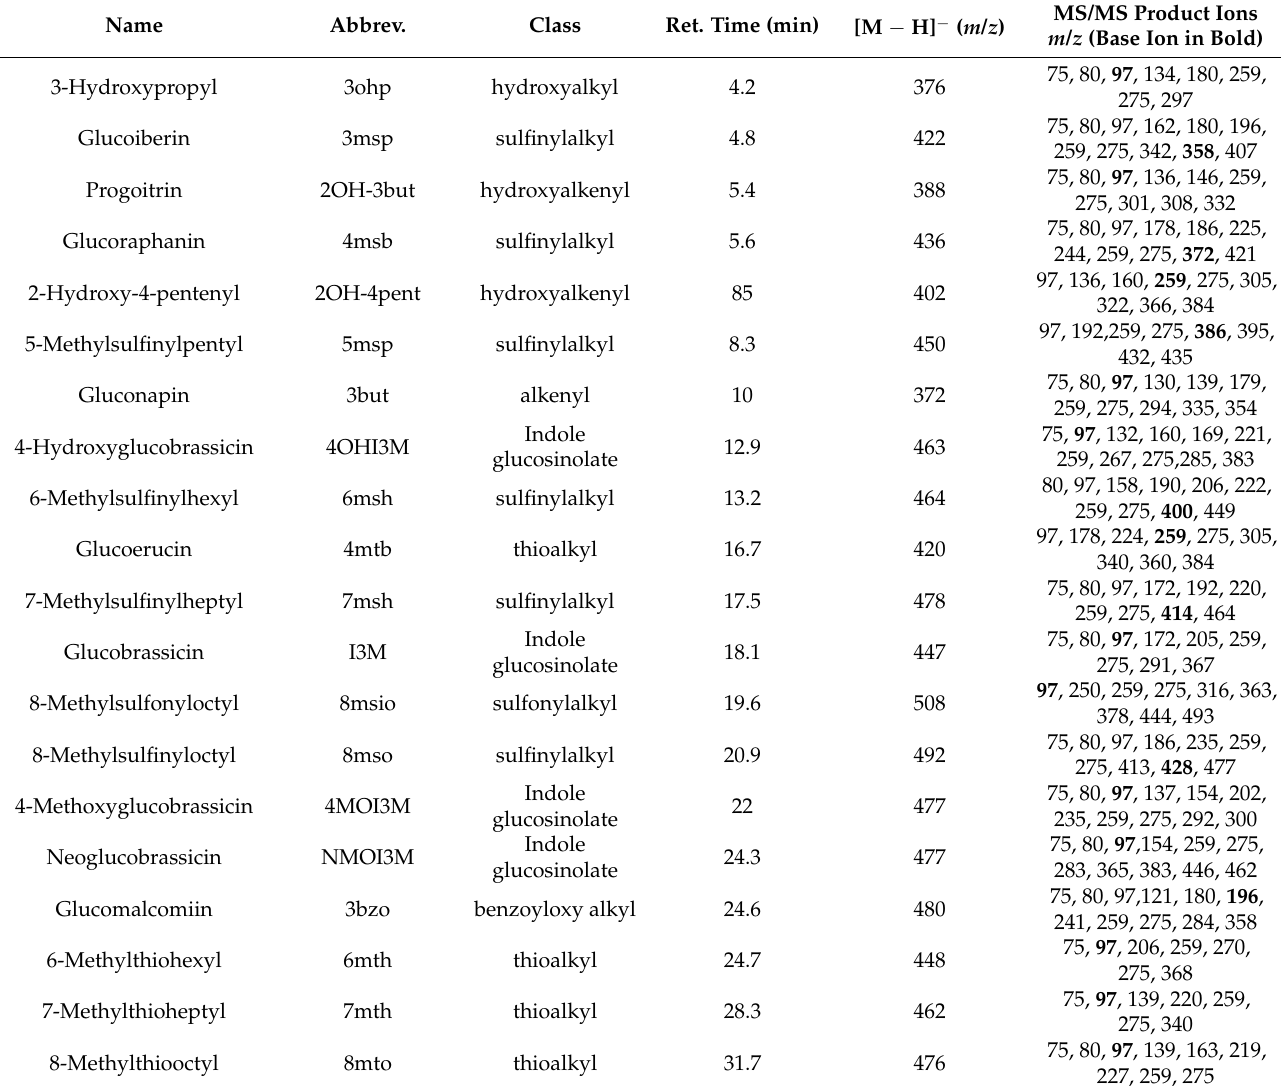
Table 4. Prec97-IDA-EPI (precursor ion survey scan of m / z 97 in combination with the information-dependent acquisition (IDA) of the enhanced product ion (EPI) dependent scan) results where 20 intact glucosinolates were tentatively identified in the root of Arabidopsis accessions grown in natural